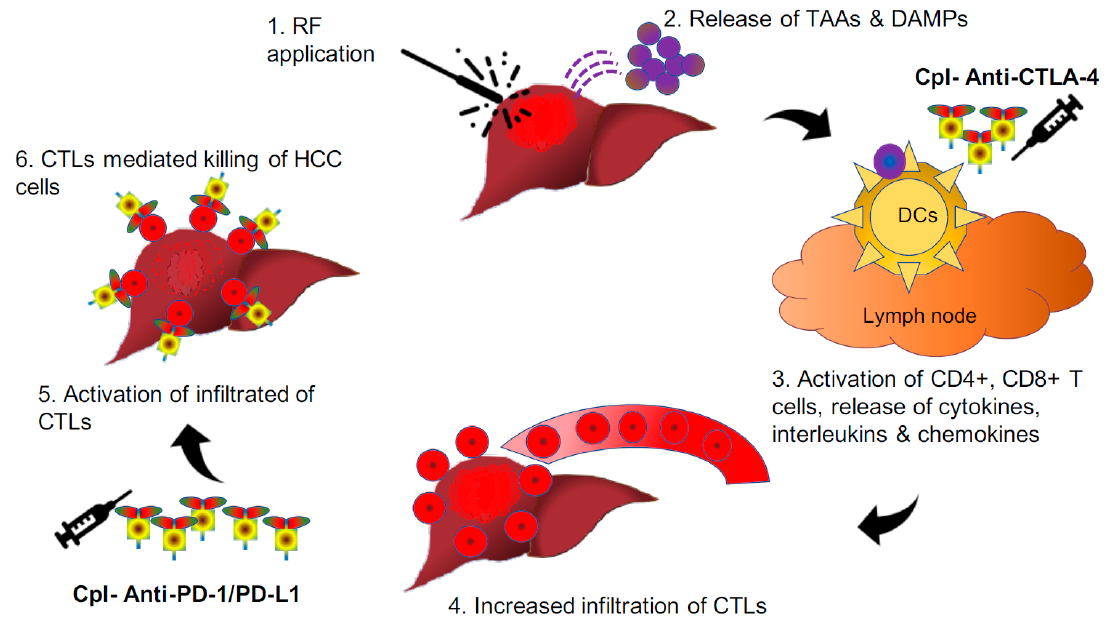
Figure 4. Pictorial depiction of radiofrequency-induced release of neoantigens and DAMPs from HCC nodules whereupon activation of CD4 + and intratumoural infiltration CD8 + T-cells. The activity of these cells gets further augmented with the introduction of checkpoint inhibitors. CD: cluster of differentiation; CpI: checkpoint inhibitors; CTLA-4: cytotoxic T-lymphocyte-associated protein-4;